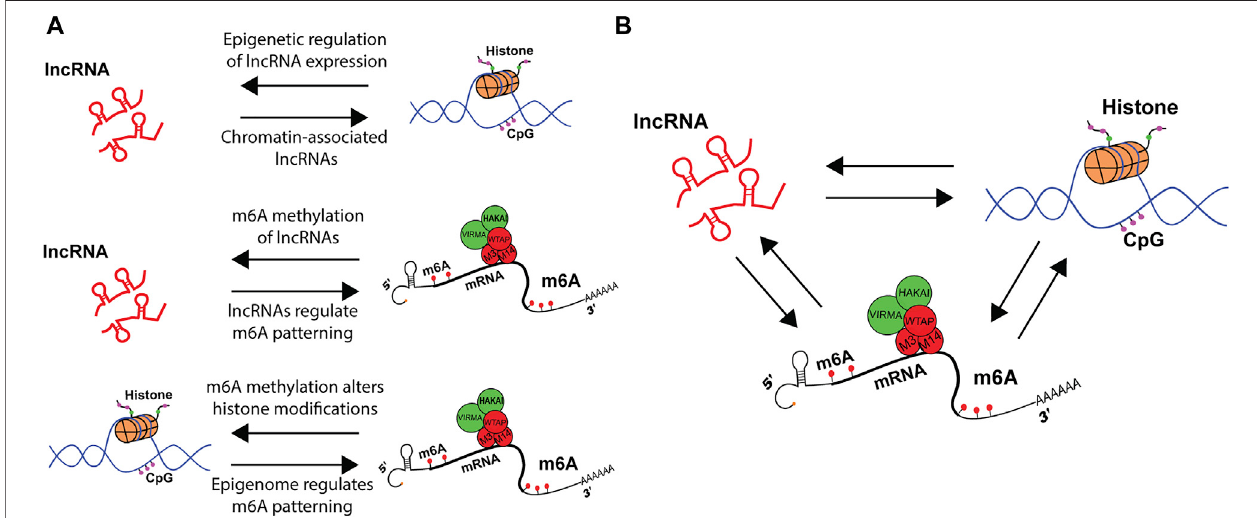
FIGURE 3 | Epigenetic crosstalk among lncRNAs, histones and m 6 A regulate gene expression. (A) schematic representation of bi-directional regulation in co- transcriptional machinery. LncRNAs can change histone dynamics, while histones control lncRNA expression. M 6 A on lncRNAs modulate RNA metabolism, while